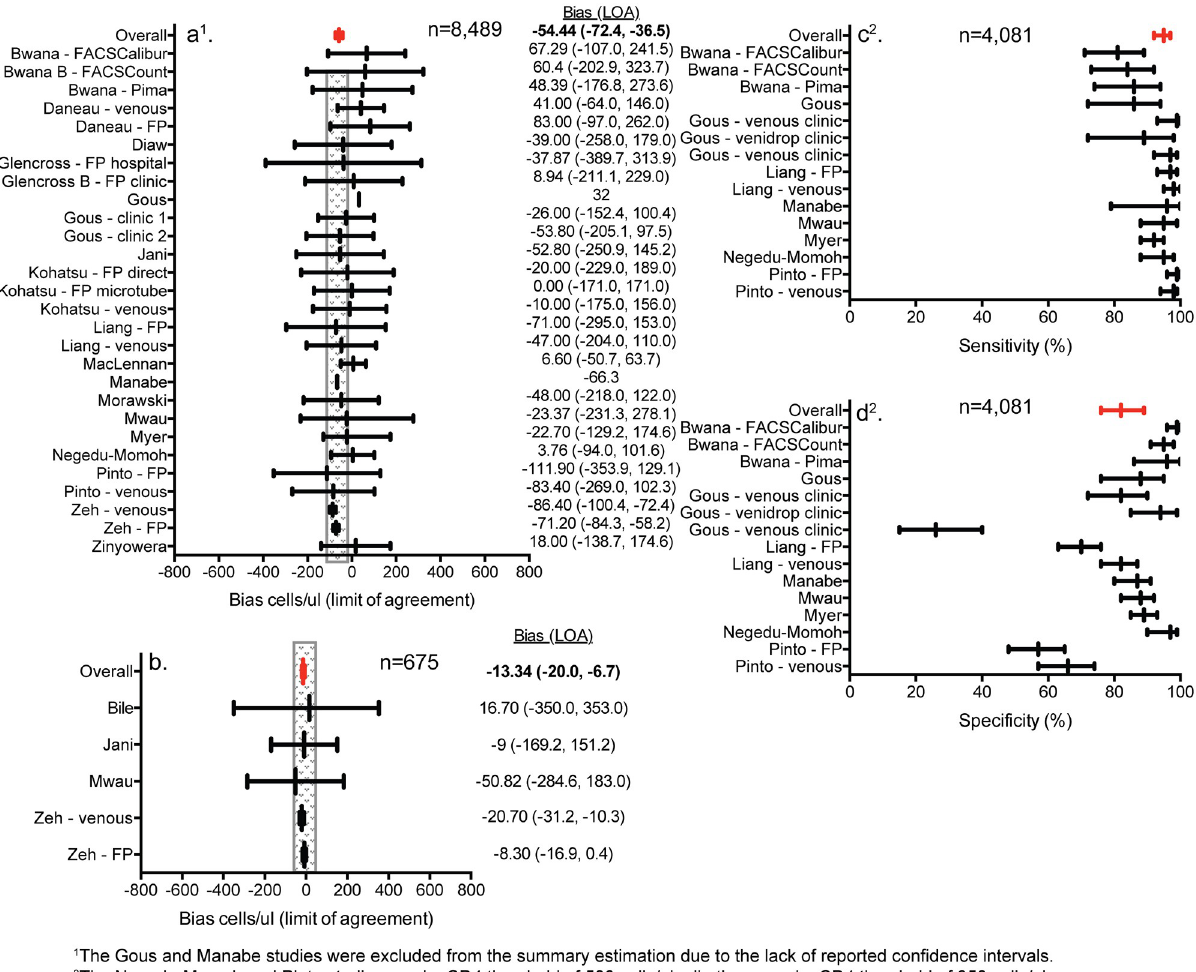
Fig 2. Forest plots of point-of-care CD4 diagnostic accuracy performance by non-laboratory staff. (a) point-of-care CD4 testing by non-laboratory staff compared to conventional laboratory-based testing by professional laboratory staff; (b) point-of-care CD4 testing by non-laboratory staff compared to point-of-care CD4 testing by professional laboratory staff; the shaded box represents +/- 50 cells/ul in (a) and (b). (c) sensitivity of correctly classifying patients below a CD4 threshold of 350 cells/ul; (d) specificity of correctly classifying patients above a CD4 threshold of 350 cells/ul.